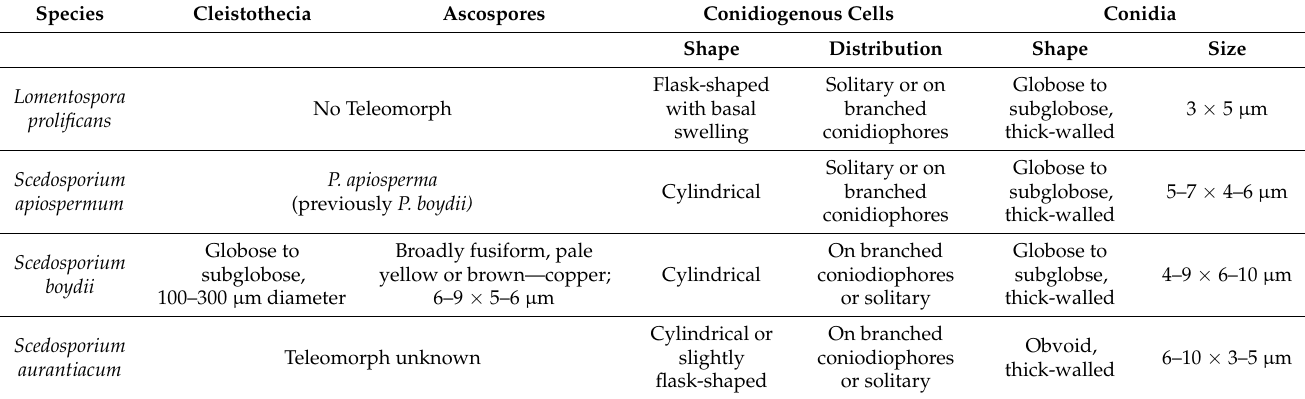
Figure 3. A and B: Microscopic morphology of Scedosporium aurantiacum ( A ) and Lomentospora prolificans ( B ) 40 × magnification. ( A ) Hyphae are septate with simple long conidiophores (arrow) bearing conidia singly or in small groups. Conidia (4–9 × 6–10 µ m) are single-celled, pale brown ovoid in shape and are rounded above with truncated bases. ( B ) Hyphae are hyaline and septate with conidia born in small groups on basally swollen, flask-shaped conidiophores (arrow). Conidia (2–5 × 3–7 µ m) are hyaline to pale brown, one-celled and oval-shaped with smooth walls. Table 2. Microscopic features of Scedosporium species and Lomentospora